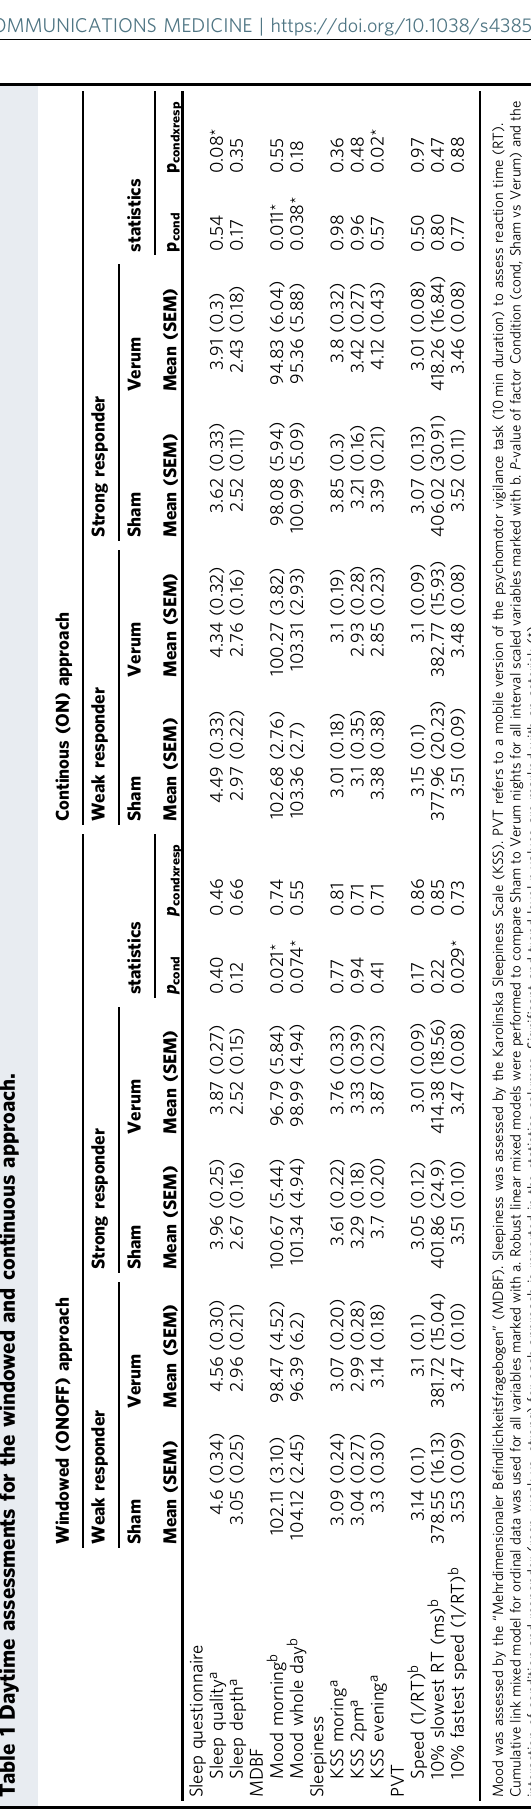
73.5 ± 1.2 years, independent samples Student ’ s t -test, t 14 = 5.5, p = 7.8 × 10 − 5 , CI = [ − 11.2, − 4.9], Cohen ’ s d = − 2.74). There was no signi fi cant difference in the gender distribution of the two groups (strong responders: fi ve females, weak responders: two females, Pearson Chi-square, χ 2(1) = 2.3, p = 0.13) or difference in their hearing threshold (Pearson Chi-square, χ 2(2) = 2.8, p = 0.24). T